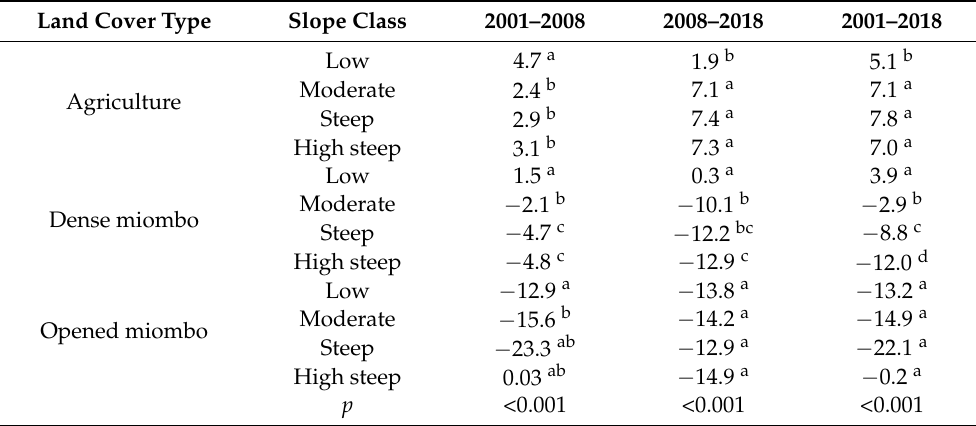
Figure 7. Spatial distribution of the different land use land cover changes across slope categories in Table 3. Land cover change distribution across the slope gradient. Means that do not share a letter are significantly different (Kruskal–Wallis test; α = 5%).